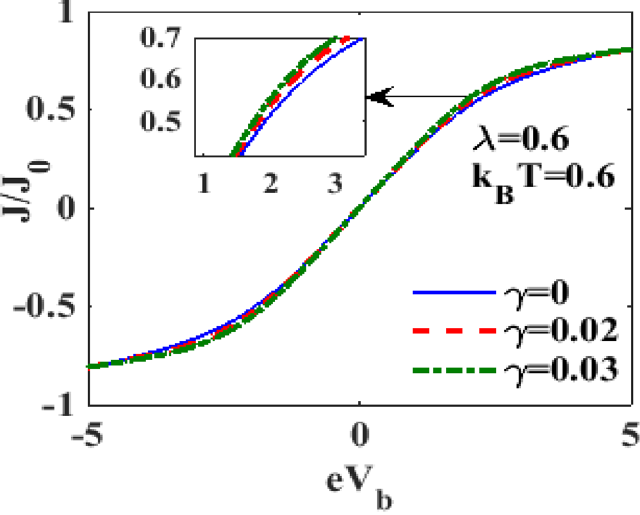
Figure 8. J / J 0 versus eV b for different values of γ at (cid:31) = 0.6, eV m = 0.5, k B T = 0.6